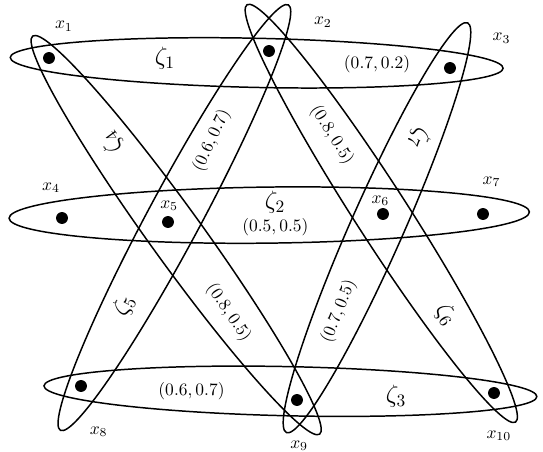
Figure 8. Seven-ROFH model for the housing schemes under consideration and their